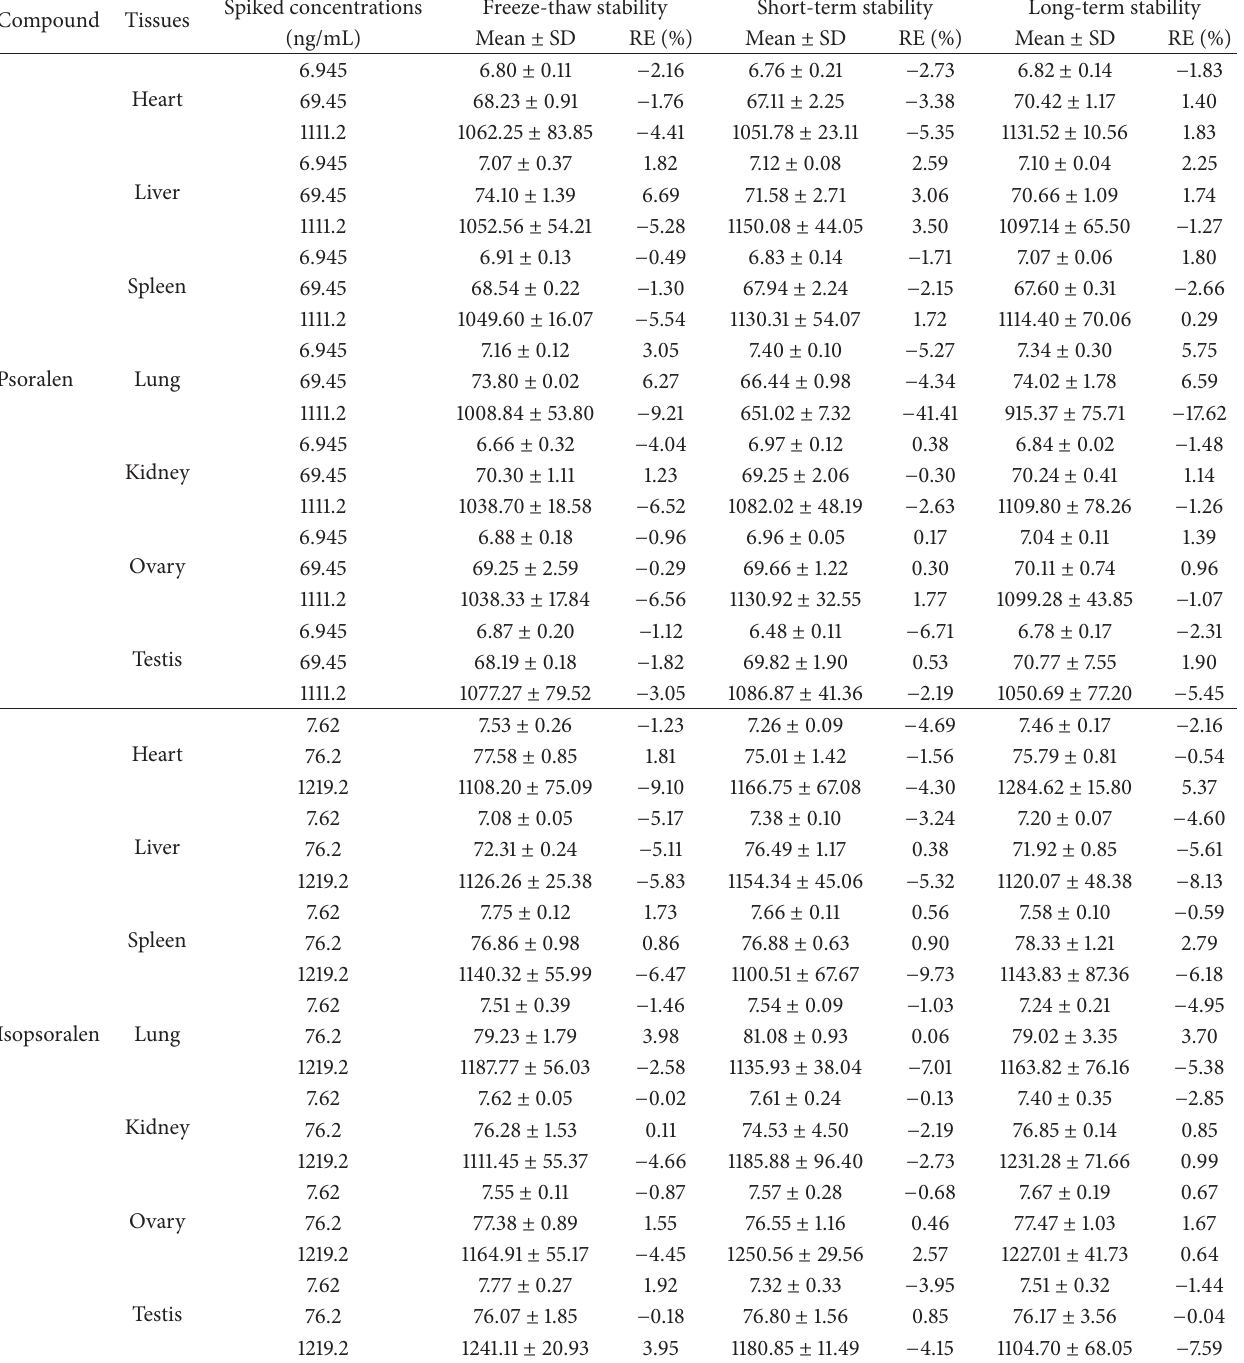
Table 3: Stability of psoralen and isopsoralen in rat tissues. ( 𝑛 = 3 for sexual organs; 𝑛 = 6 for other tissues). Compound